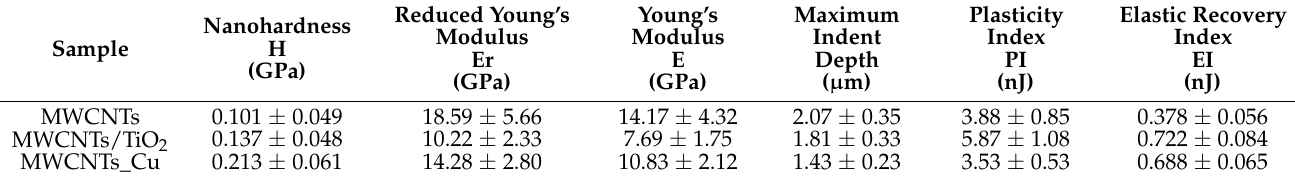
Table 5. Mechanical properties and maximum indent depth for the substrate and achieved coatings. Reduced Young’s Nanohardness Modulus Sample H (GPa)